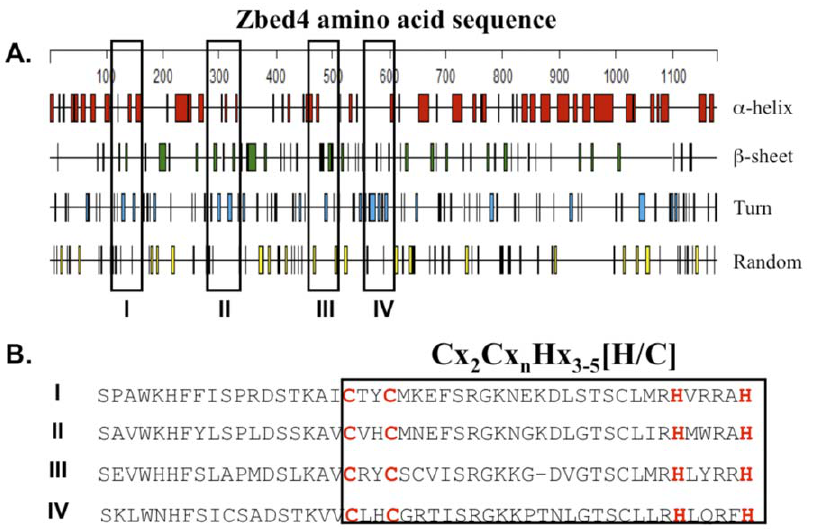
Figure 3. Prediction of secondary structures for Zbed4 using the Garnier-Robson algorithm . A . Position of a -helices, b -sheets, turns and random amino acid sequences in the Zbed4 1,168 amino acid sequence. Predictions performed by two different programs, DNASTAR (Lasergene) and the FASTA Sequence Comparison web resource at the University of Virginia, gave the same results. Boxes I, II, III and IV indicate the position of BED zinc-finger motifs in Zbed4. B . The amino acid sequence of the four boxes in A show the specific signature of the BED-type zinc-fingers present in Zbed4 containing the characteristic cystines and histidines (red).